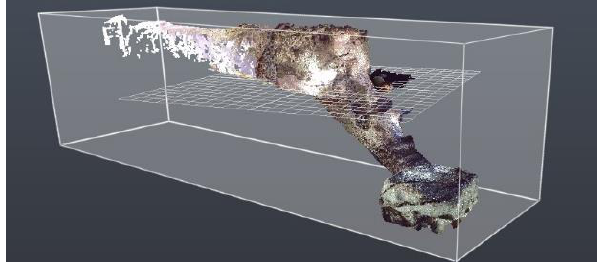
Figure 8: Access to the Ipi’s sarcophagus. Final scan, 2018.